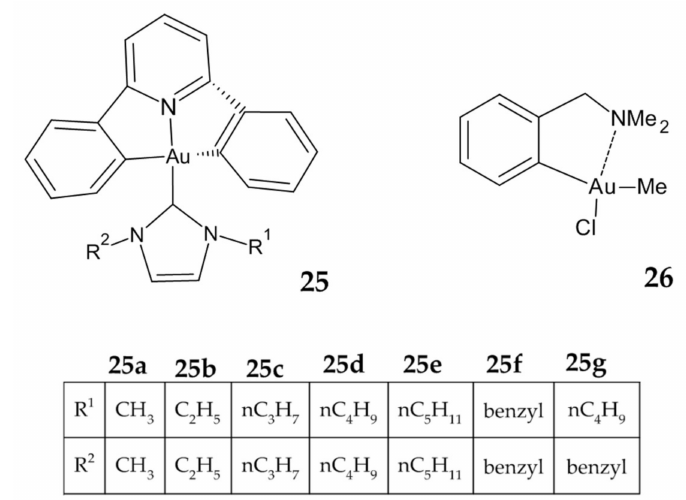
Figure 10. Cyclometalated Au(III) complexes 25 , 26 .